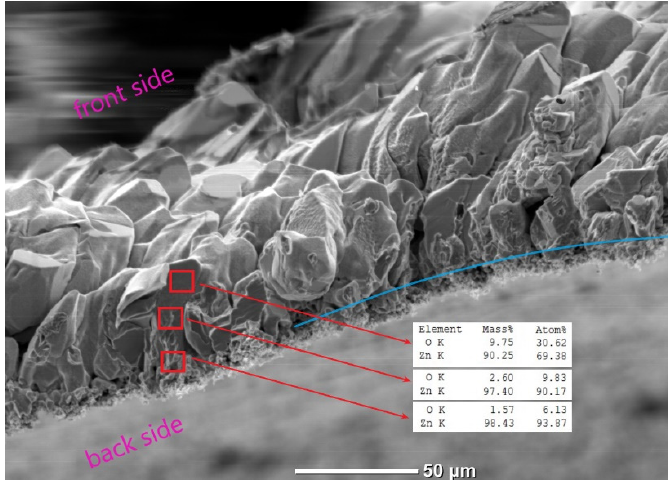
Figure 6. SEM image of the rupture region of the N1 film. Compositions of elements are shown for the areas marked with red squares. The blue line shows the approximate position of the boundary between the microcrystalline and nanocrystalline parts of the film.